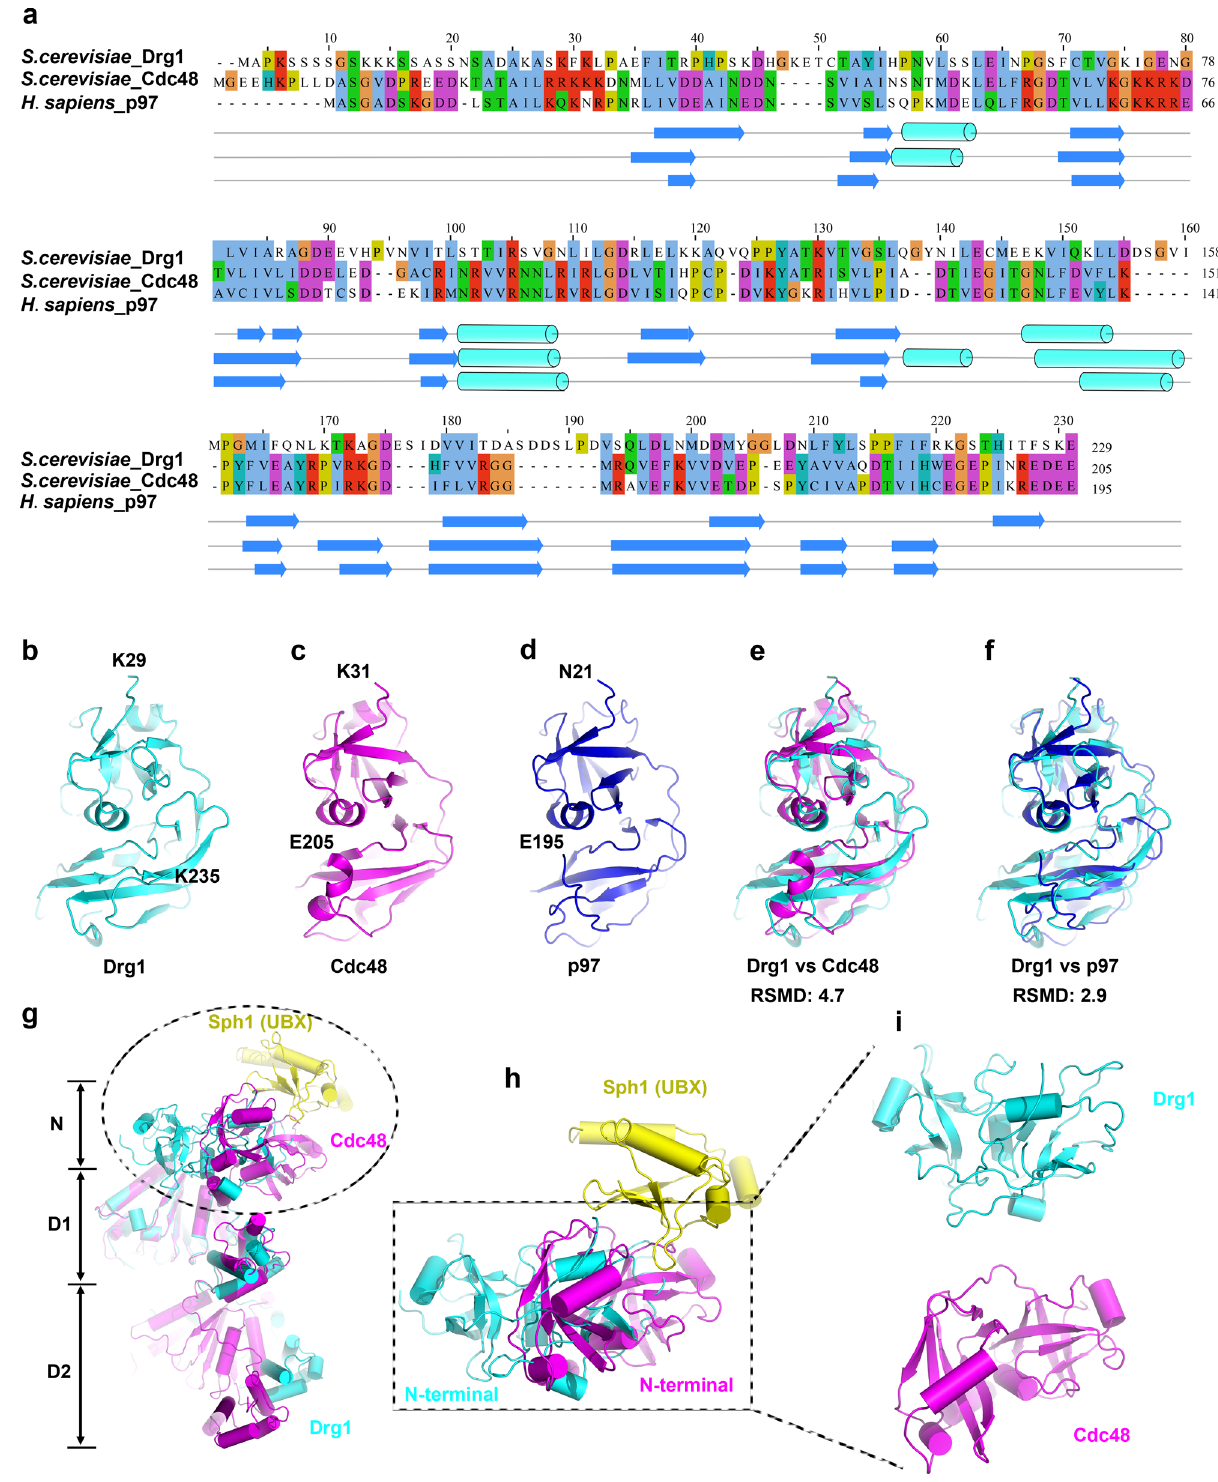
Fig. 4 | Comparison of the NTDs from S. cerevisiae Drg1, Cdc48, and H. sapiens p97. a Sequence alignment of the NTDs from S. cerevisiae Drg1, Cdc48, and H. sapiens p97. Secondary structures are also shown. b – d The atomic models of the NTD of S. cerevisiae Drg1, Cdc48 (PDB 6OPC) 11 , and H. sapiens p97 (PDB 5FTK) 8 . e Superimposition of the NTDs of S. cerevisiae Drg1 and Cdc48 (RMSD 4.7Å). f SuperimpositionoftheNTDof S.cerevisiae Drg1and H.sapiens p97(RMSD2.9Å). g Superimpositionof S.cerevisiae Drg1andCdc48(PDB6OPC).Thetwomodelsare